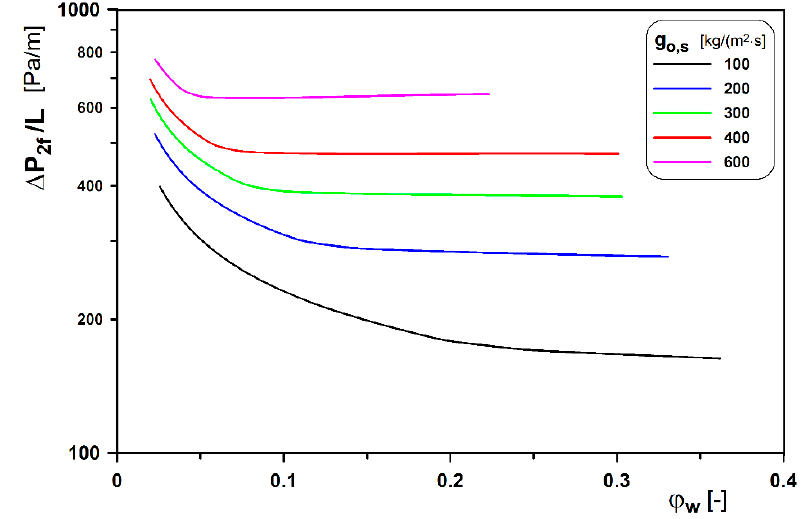
Figure 3. Variations in resistance of oil-water flow recorded for η r =100.